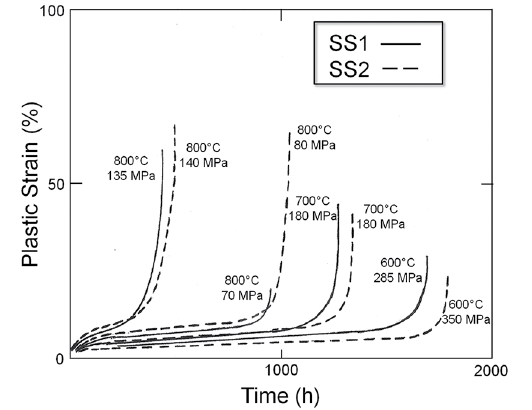
Figure 1. Typical strain vs. time curves for SS1 and SS2 type 316 steels creep tested at 600, 700 and